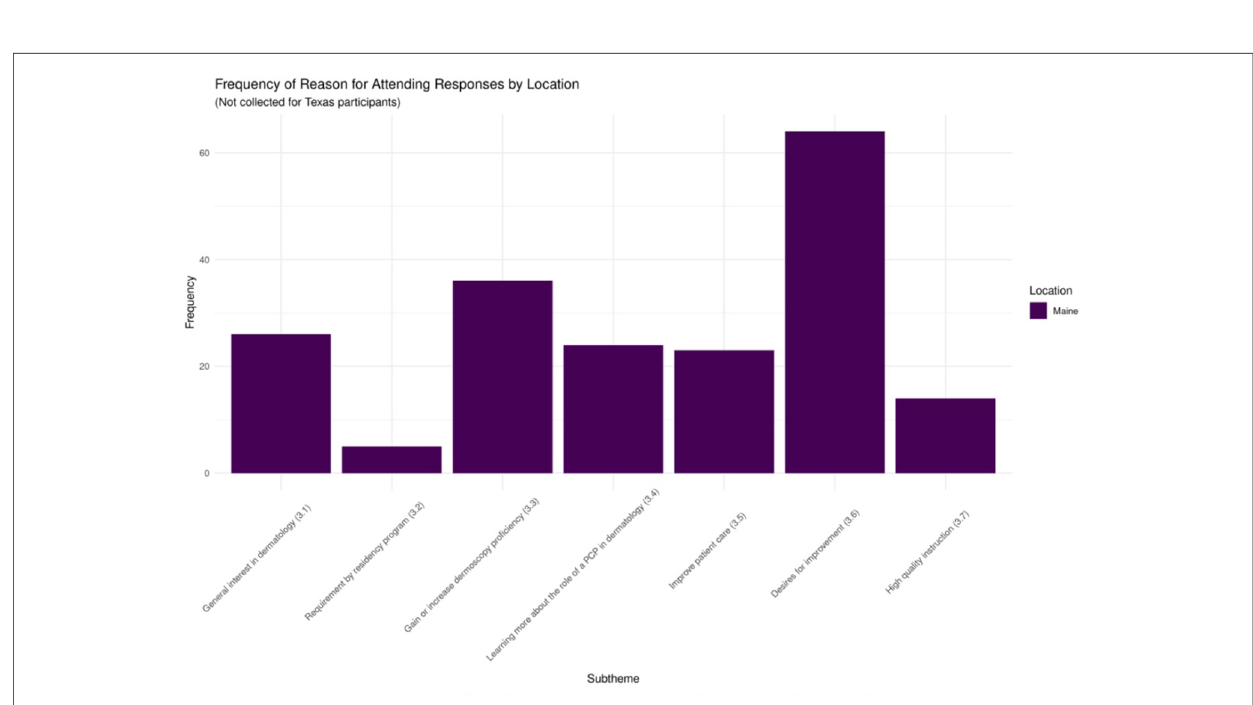
FIGURE 3 Results relating to Theme 3 (reasons for attending) by